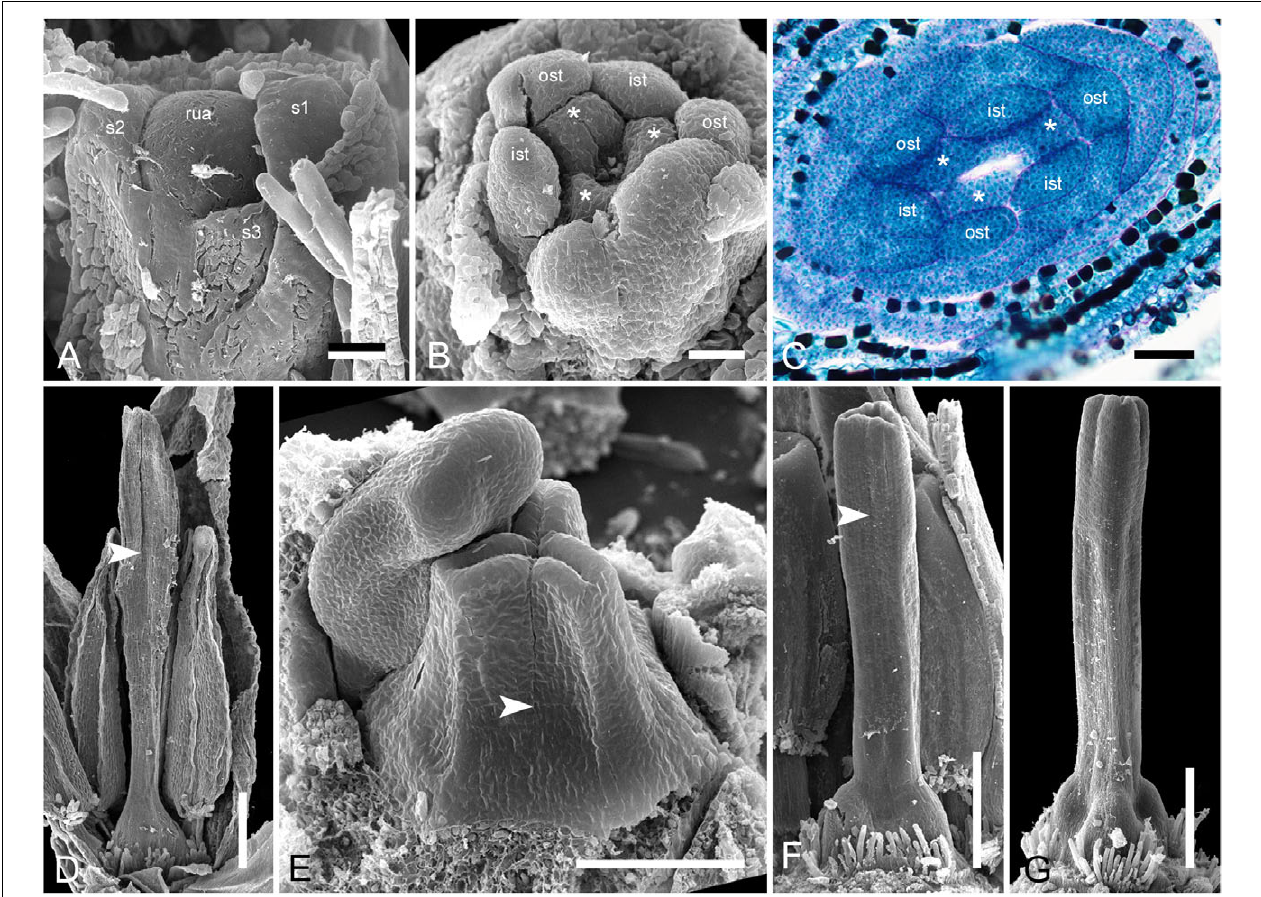
FIGURE 12 | Flower development in Rapateoideae. Monotrema aemulans and Potarophytum riparium . (A–D) Floral development in Monotrema aemulans (A) Young RU with spirally initiating phyllomes, viewed from adaxial side. Phyllomes are labeled in the order of their initiation. (B) Very young nearly free plicate carpels. (C) Cross-section of flower at stage as in panel (B) to show that carpels are basally connate. (D) Late gynoecium. Lines of postgenital fusion in the upper third of style. (E–G) Late gynoecium development in Potarophytum riparium . (E) Young gynoecium with clearly visible lines of postgenital fusion. (F,G) Late gynoecia with weakly visible lines of postgenital fusion. Arrowheads show visible boundaries of postgenital fusion in asymplicate zone. ist, inner stamen; ost, outer stamens; rua, RU apex; s, phyllomes on RU axis; *, carpels. Scale bars = 30 mkm in panels (A,B) , 50 mkm in panels (C,E) , and 300 mkm in panels (D,F,G)